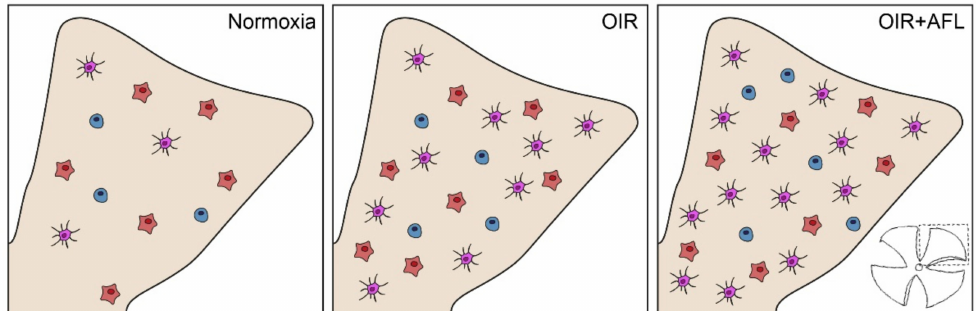
Figure 3. Schematic representation of Iba1+ cells in P17 flat-mounted normoxic, OIR and OIR+AFL retinas. Round cells are shown in blue, amoeboid in orange, and ramified in purple. One of the four quadrants in which retinal tissues were cut for flat-mounting (bottom right) is schematically shown in beige for each condition (Normoxia, OIR and